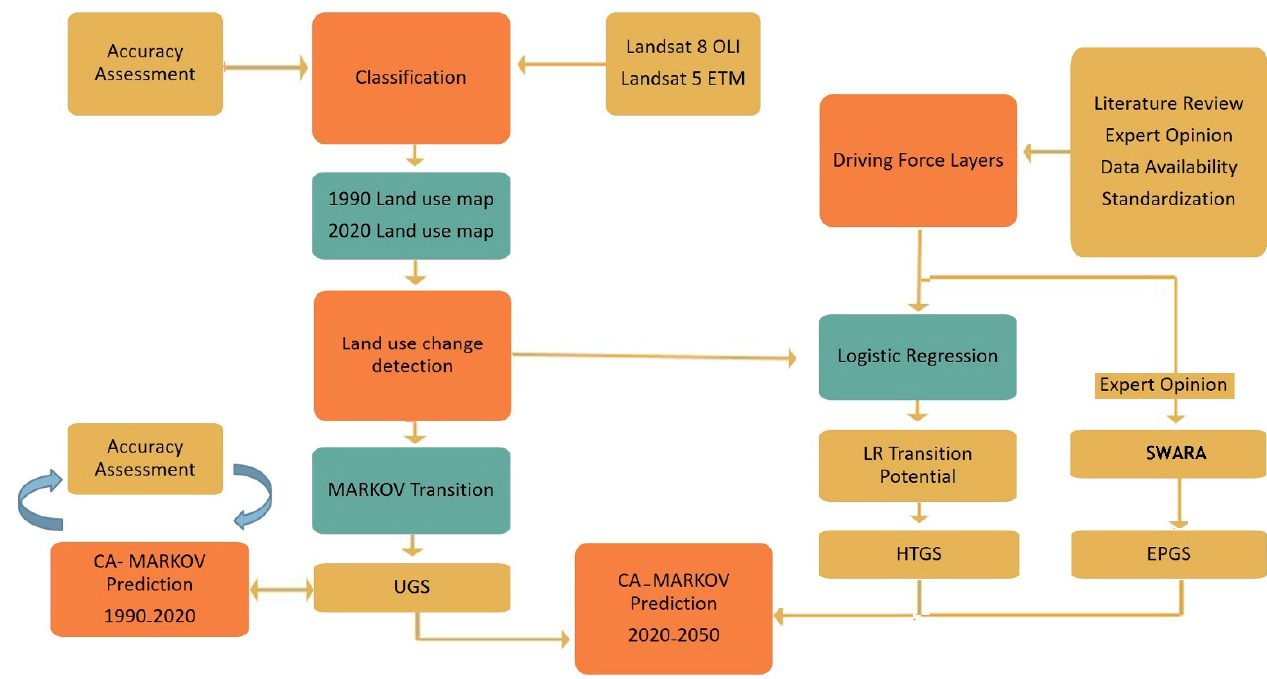
Figure 1. Research flowchart.